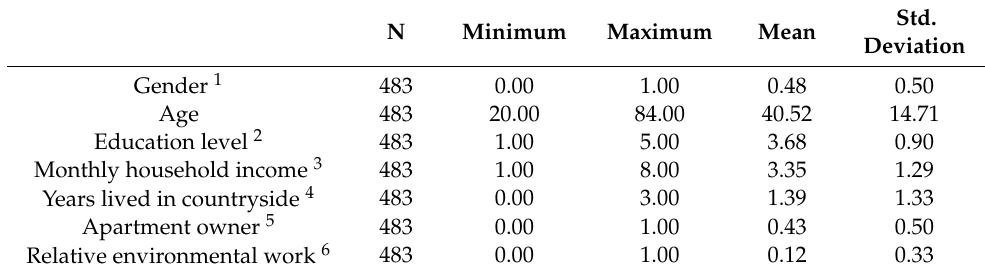
Table 9. Description of the sample.